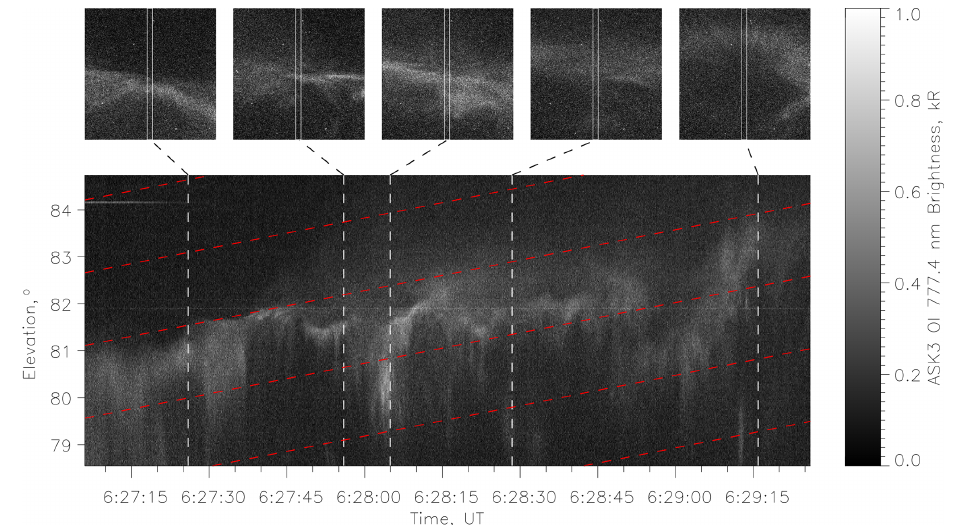
Figure 7. Keogram made using a vertical cut through the centre of the ASK3 (OI 777.4nm) field of view to show movement of the auroral arc during event 2. White dashed lines mark the times of the images shown above the keogram. The white boxes indicated in the images show the location of the keogram cut. Red dashed lines indicate the arc motion, with their slope corresponding to the arc’s speed in the vertical cut